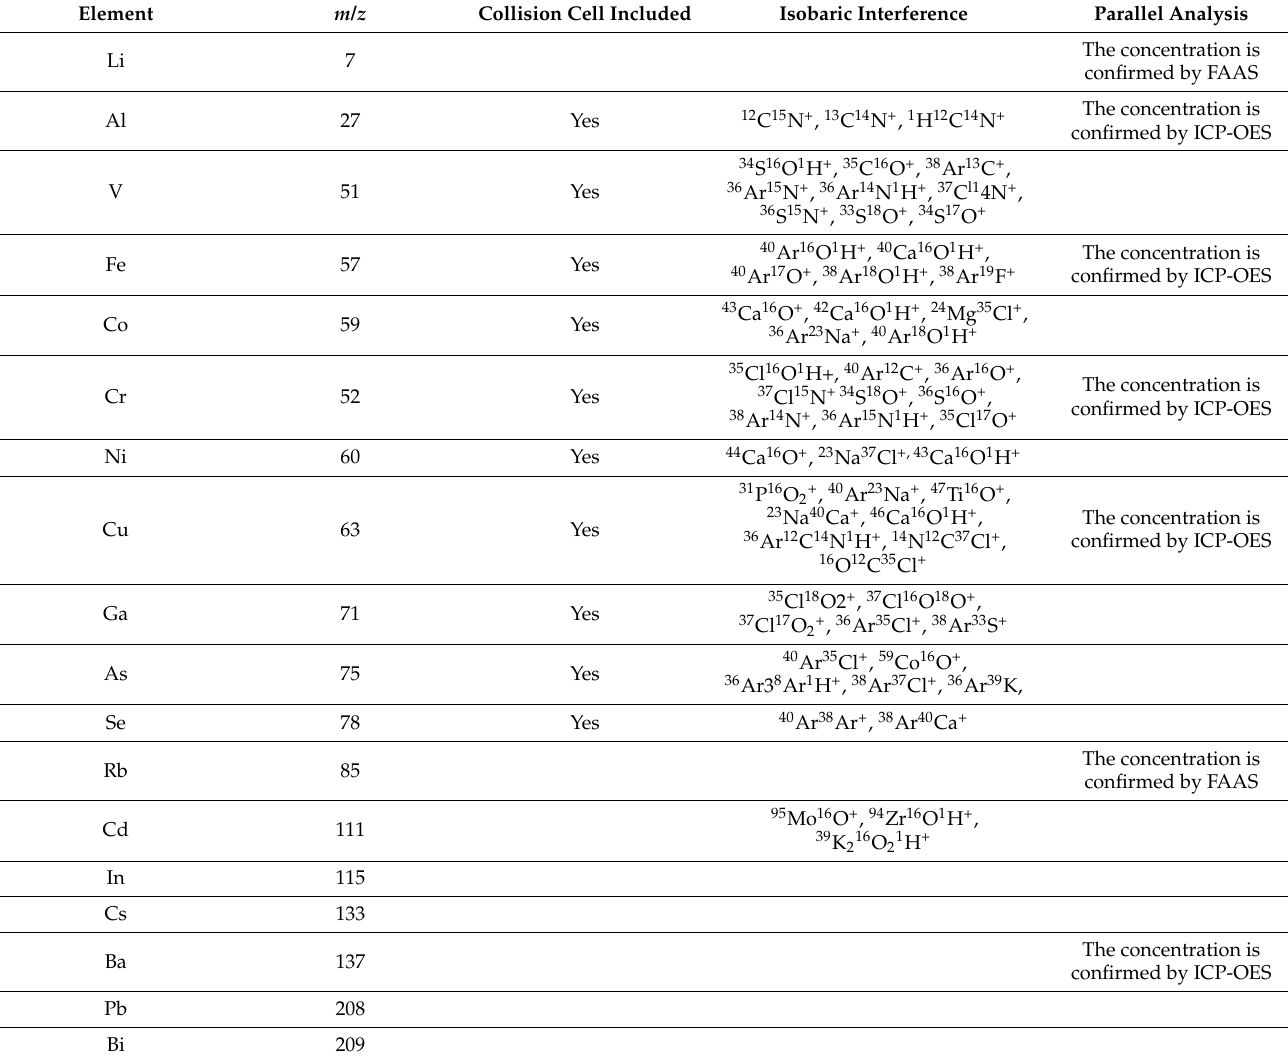
Table 4. Experimental conditions for ICP-MS